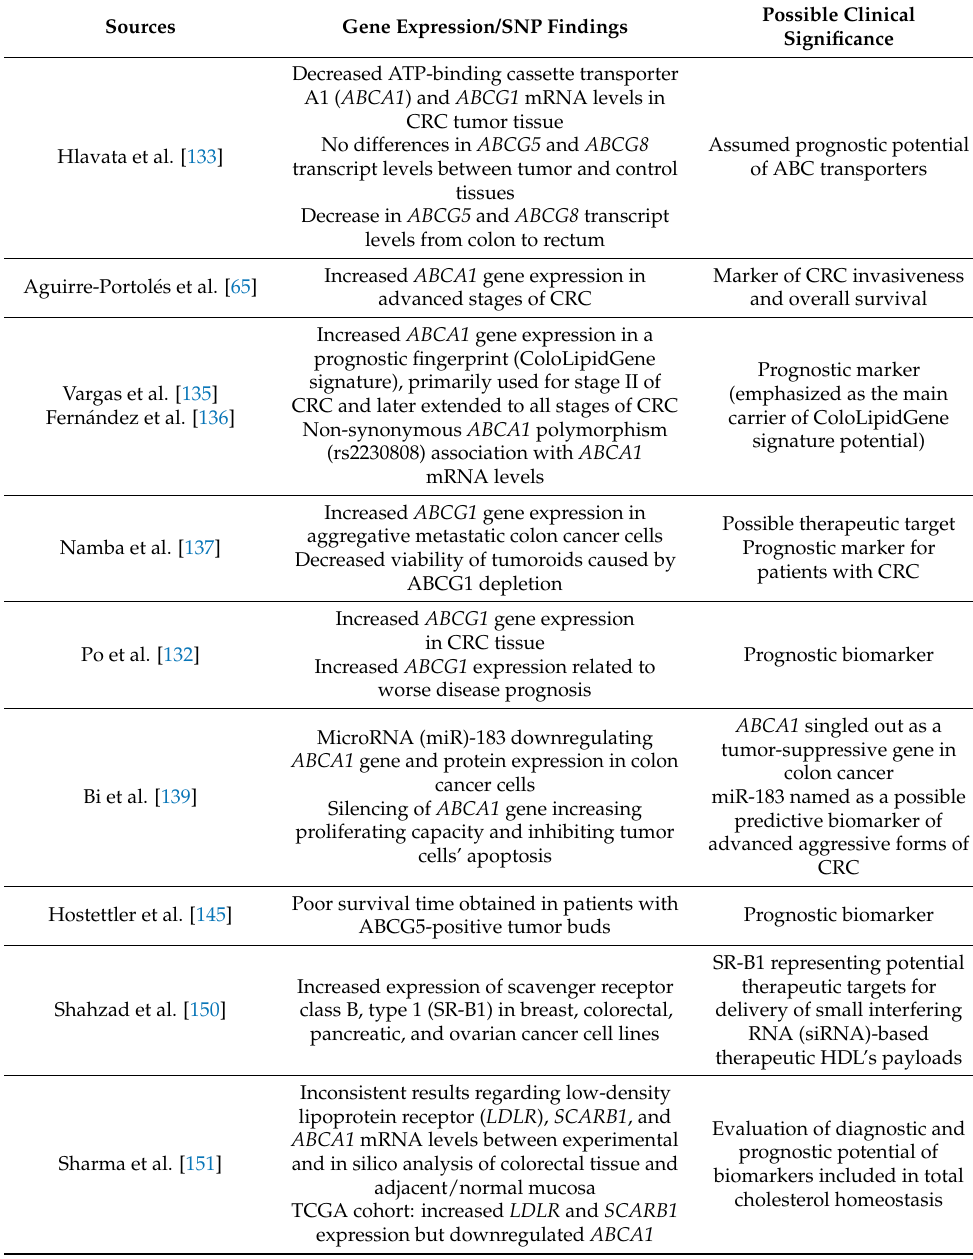
Table 1. Relevant gene expressions and single-nucleotide polymorphisms (SNPs) related to HDL homeostasis in